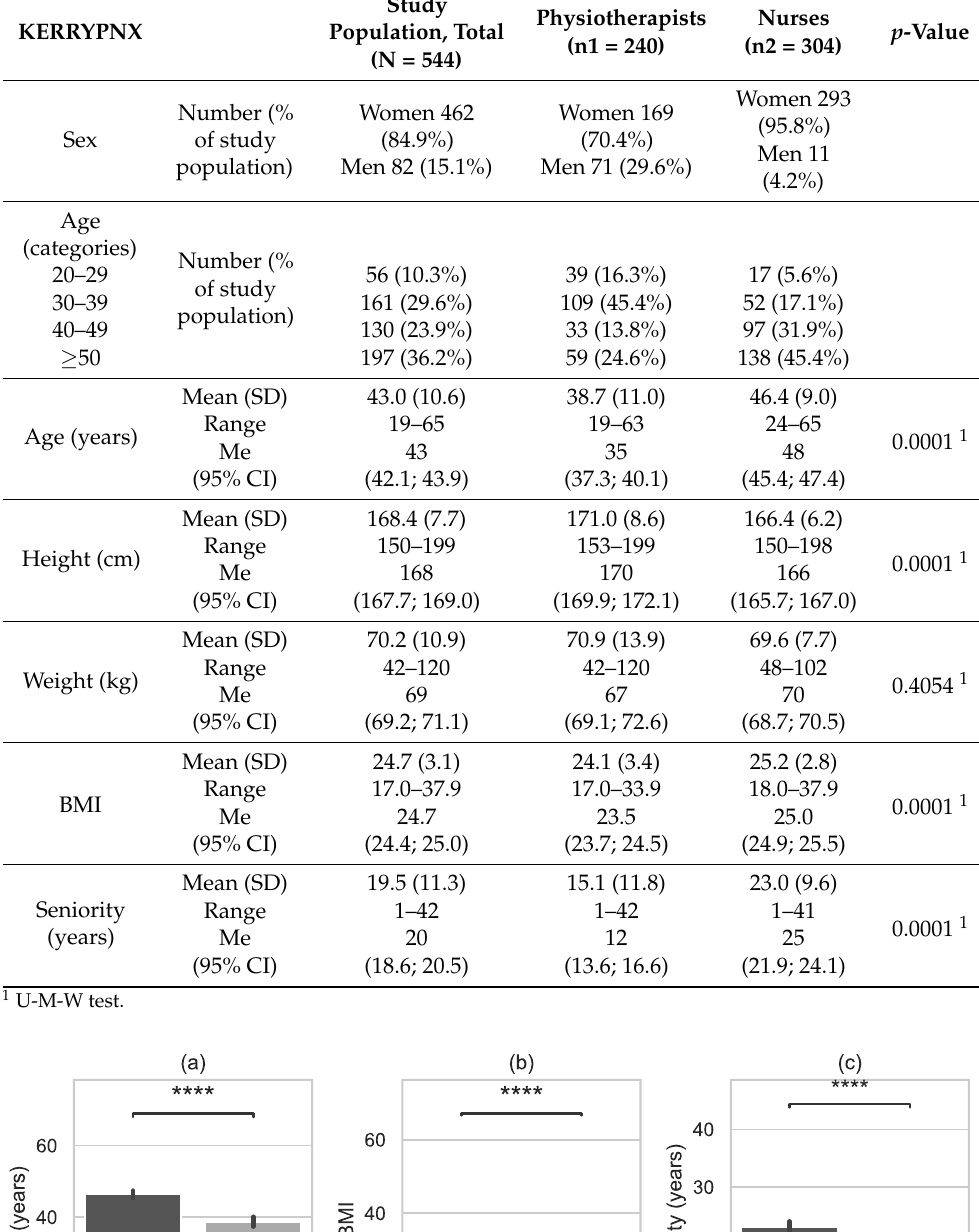
Table 1. Baseline characteristics of the study population across categories of nurses and physiotherapists.